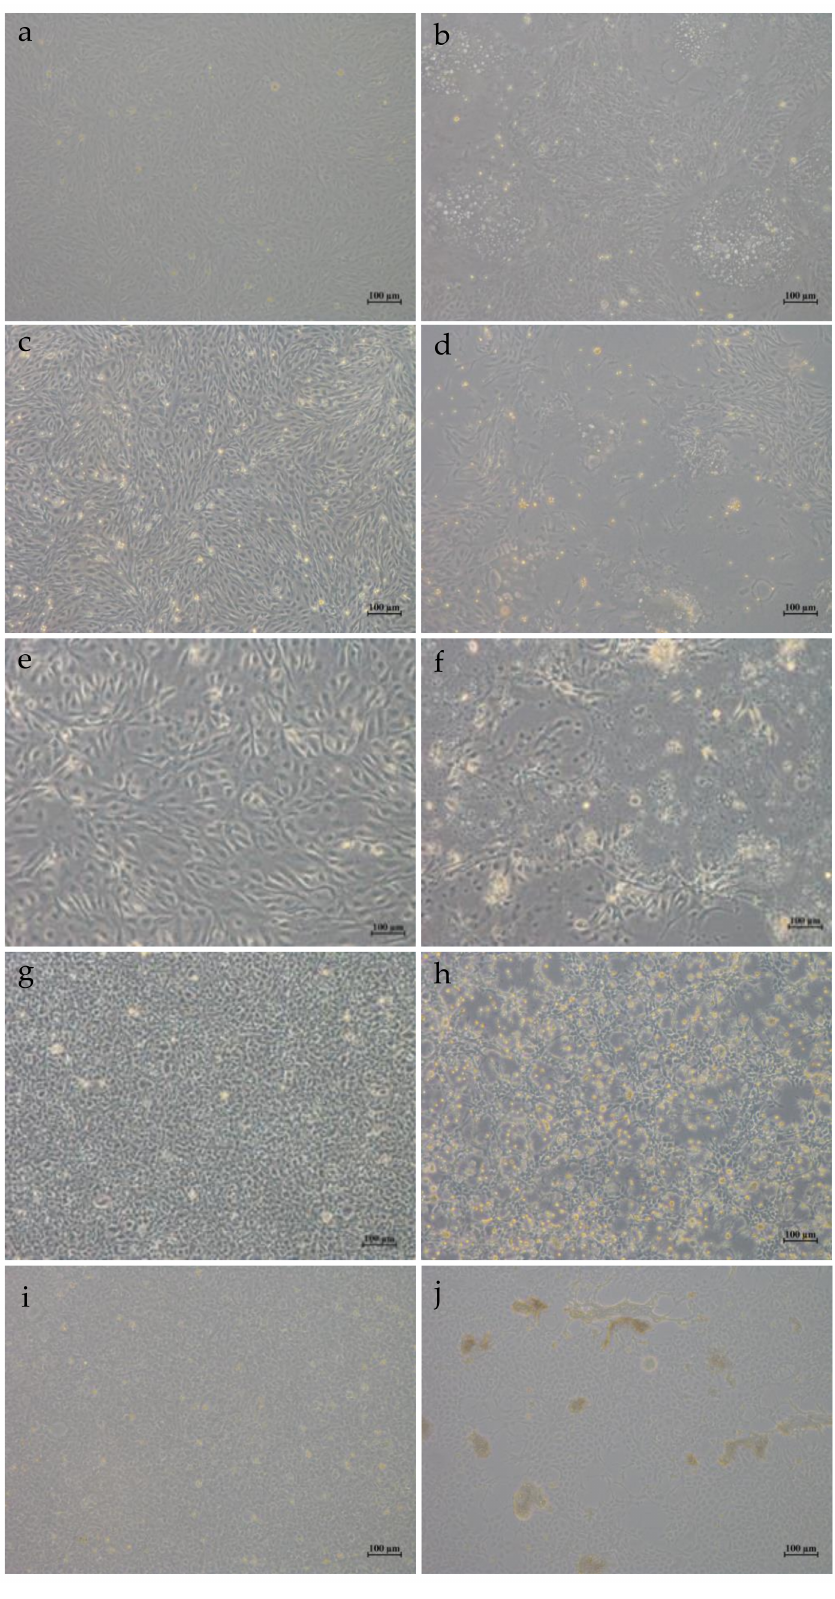
Figure 7. Cytopathic effect in different cell lines after 48 h of virus infection. ( a , c , e , g , i ): Ctenopharyngodon idelus kidney (CIK), grass carp liver (L8824), gibel carp brain (GiCB), Epithelioma papulosum cyprinid (EPC), grass carp ovary (GCO) cells uninfected with HGCRV, respectively; ( b , d , f , h , j ): CIK, L8824, GiCB, EPC, GCO cells infected with HGCRV,